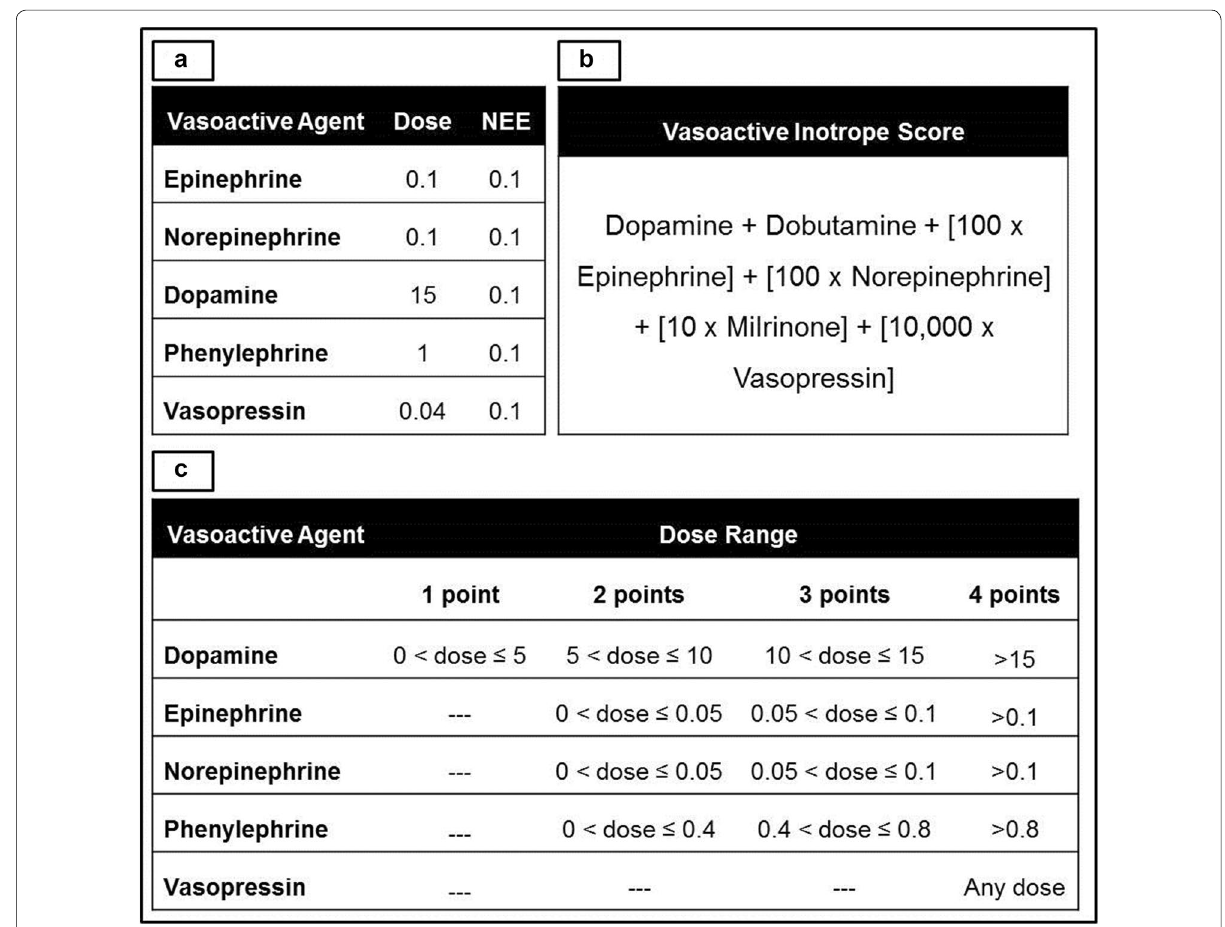
Fig. 1 Vasoactive medication scoring systems. Conversion and scoring systems used in norepinephrine equivalents (1A), vasoactive inotrope score (1B) and cumulative vasopressor index (1C). All doses in mcg/kg/min except vasopressin, which is U/min. NEE norepinephrine